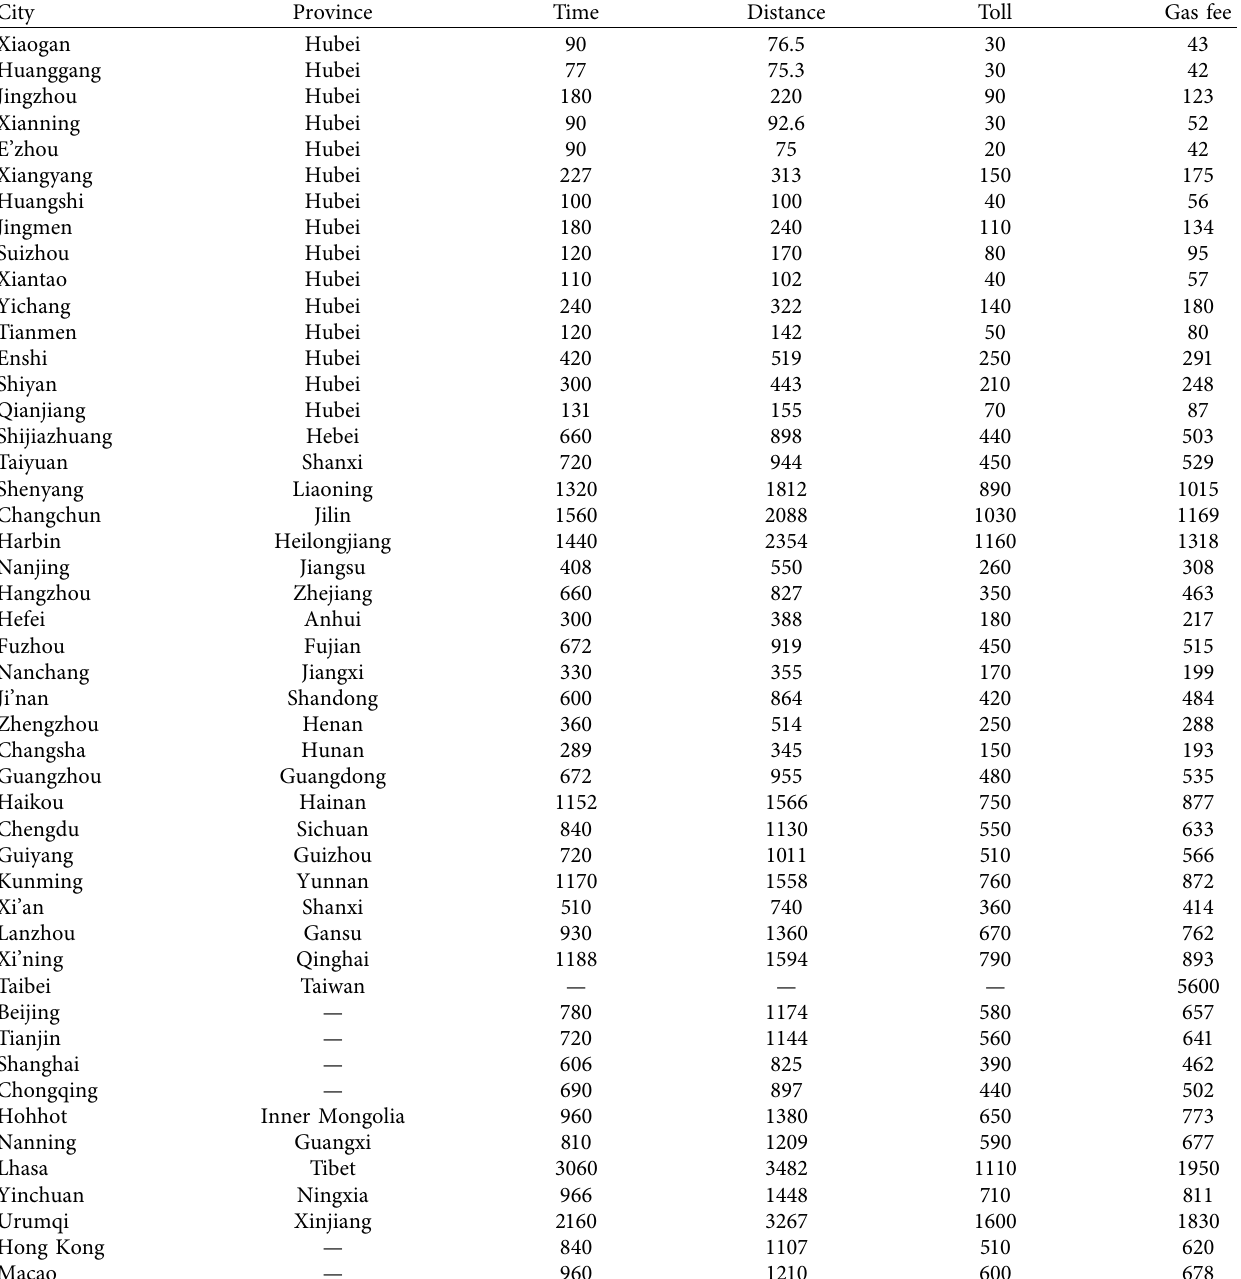
Table 1: Automobile transportation